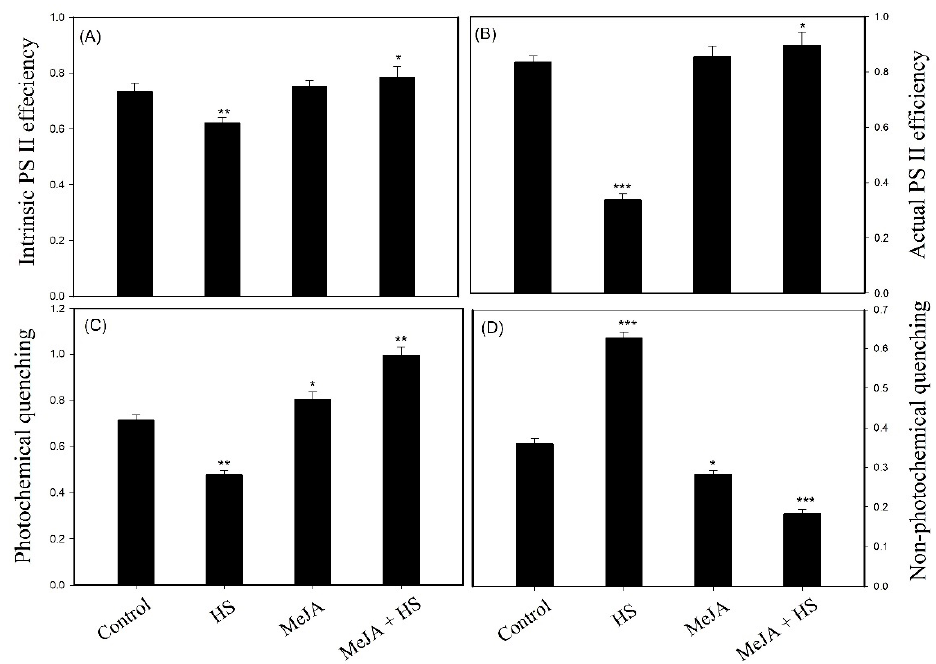
Figure 1. Intrinsic PS II efficiency ( A ), actual PS II efficiency ( B ), photochemical quenching ( C ), and non-photochemical quenching ( D ) in wheat leaves at 30 DAS. Plants were treated with MeJA (10 µM) at 42 °C (heat stress) or 25 °C (no stress). Data are presented as mean ± SE ( n = 4). Significantly different values are marked with an asterisk between control and treatments (* p < 0.05, ** p < 0.01, *** p < 0.001), as determined by Tukey’s test. DAS, days after sowing; HS, heat stress; MeJA, methyl jasmonate. Table 5. Chl a fluorescence measurement in wheat leaves at 30 DAS. Plants were treated with MeJA (10 µ M) at 42 ◦ C (heat stress) or 25 ◦ C (no stress). Minimal fluorescence (Fo), maximal fluorescence (Fm), maximal variable fluorescence (Fv), and Fv/Fm ratio, where Fv = (Fm − Fo), reaction center-to-PS II antenna absorption ratio (RC/ABS), performance index (PI), and Area, region above the chlorophyll fluorescence OJIP curve between Fo and Fm. Data are presented as mean ± SE ( n = 4). Significantly different values between control and treatments are marked with an asterisk (* p < 0.05, ** p < 0.01, *** p < 0.001), as determined by Tukey’s test. DAS, days after sowing; HS, heat stress; MeJA, methyl jasmonate. Treatments Parameters